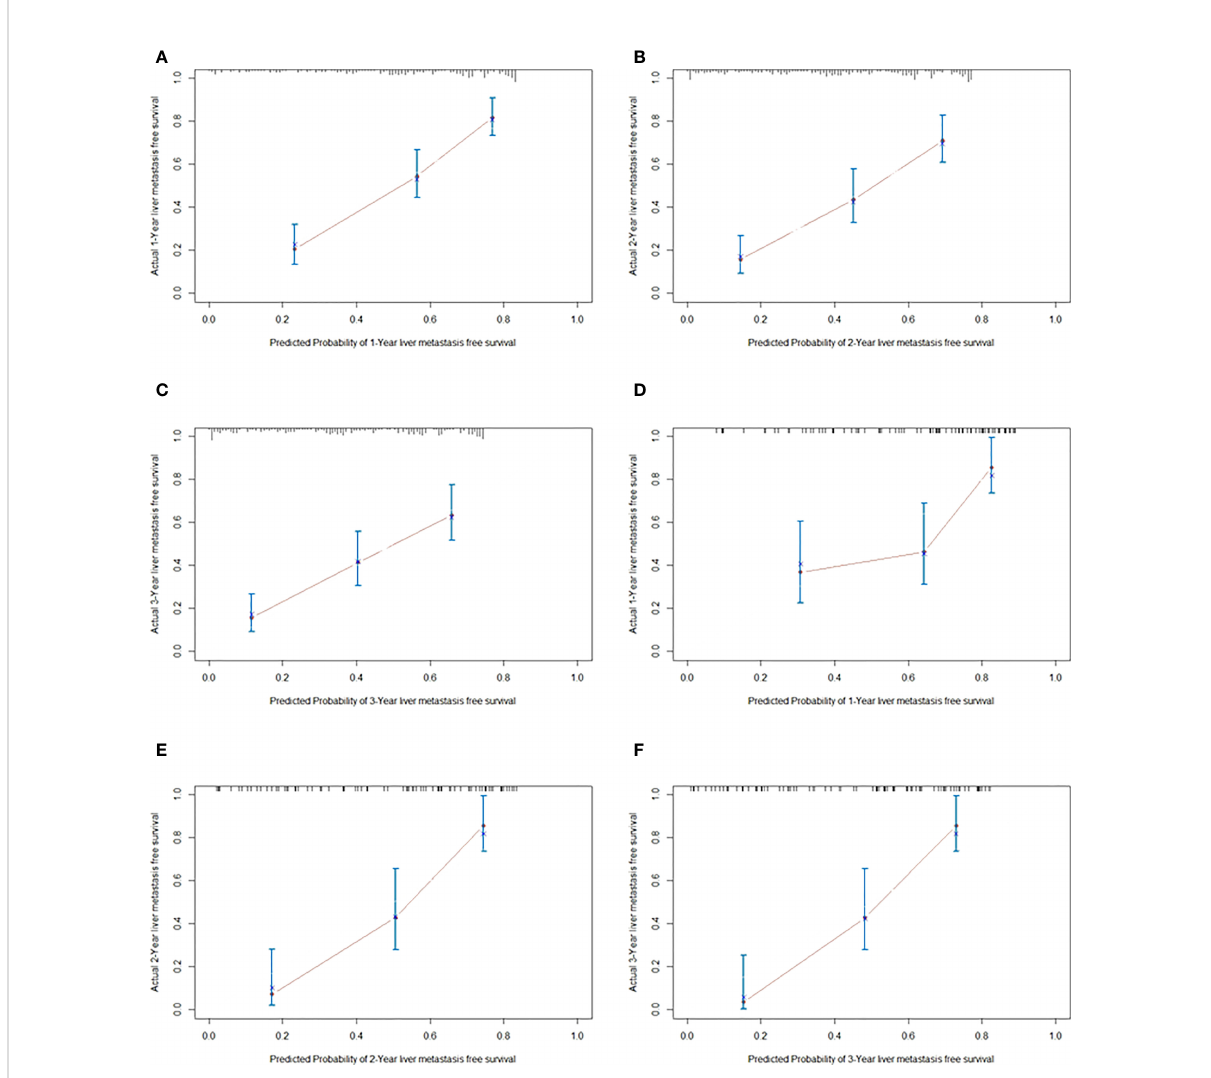
FIGURE 3 The calibration curves for predicting liver metastasis-free survival at 1 year (A) , 2 years (B) and 3 years (C) in the training cohort, and those at 1 year (D) , 2 years (E) and 3 years (F) in validation cohorts,